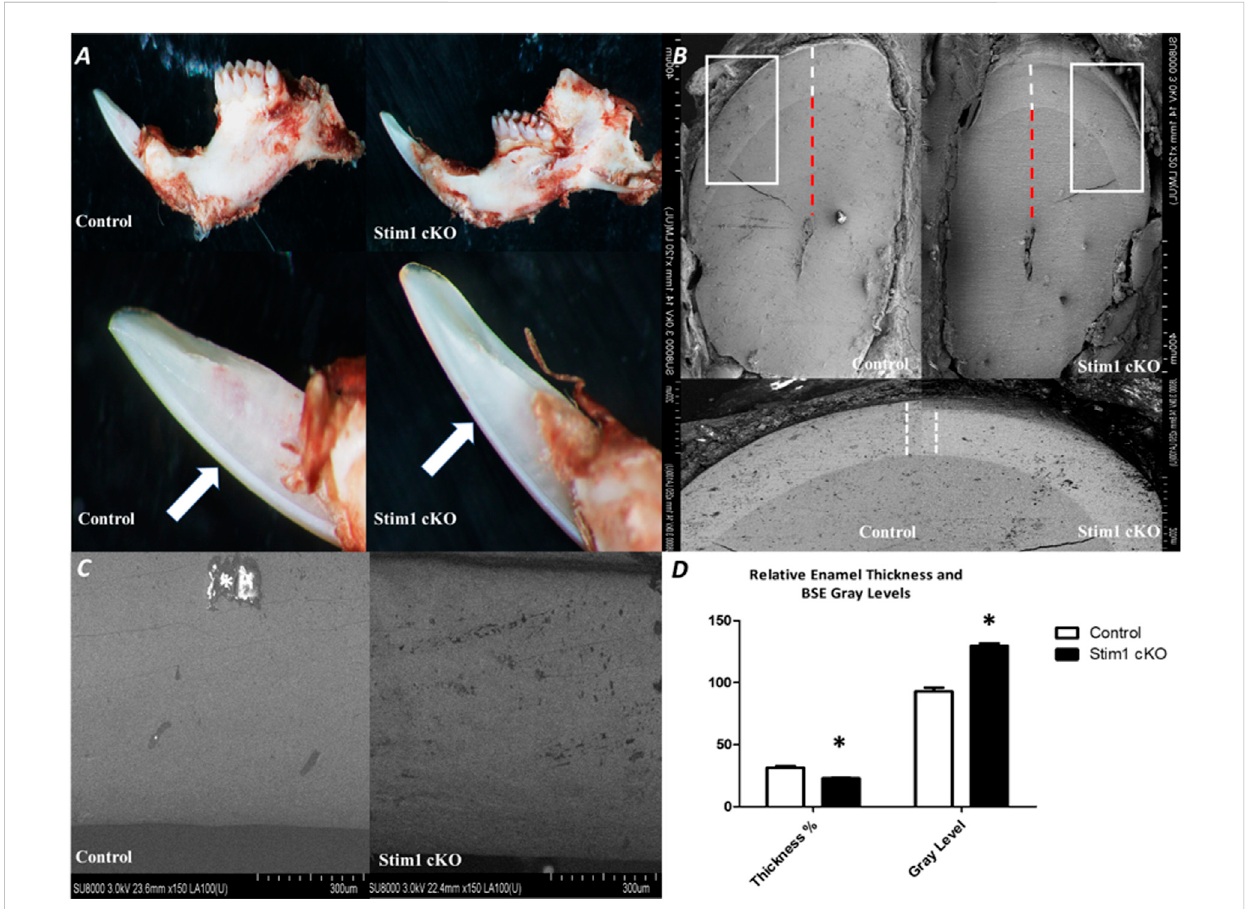
FIGURE 2 Phenotypic analysis of Stim1 cKO incisors (A) Gross visual inspection of the P28 incisors of Stim1 cKO mice showed an abnormal chalky-white appearance that is often associated with hypomineralization or enamel loss. Stim1cKO mice showed a greatly reduced enamel thickness closer to the incisor tips (arrows). (B) Stim1 cKO incisor displayed a clearly reduced enamel thickness (white dotted line) as compared with control. For quantitative analysis, we measure the enamel thickness and dividedit by thetotal of enamel and dentin (red dotted line) to attaina more representative measure of enamel thickness relative to the crown. (C) Backscatter scanning electron microscopy of mid labial surface of control and Stim1 cKO incisors. The Stim1 cKO incisors showed a weaker signal with higher gray levels associated with more abraded enamel surfaces. Whitespots are overcharging artifacts (star). (D) Quantitative analysis of relative enamel thickness and BSE gray levels (* p <